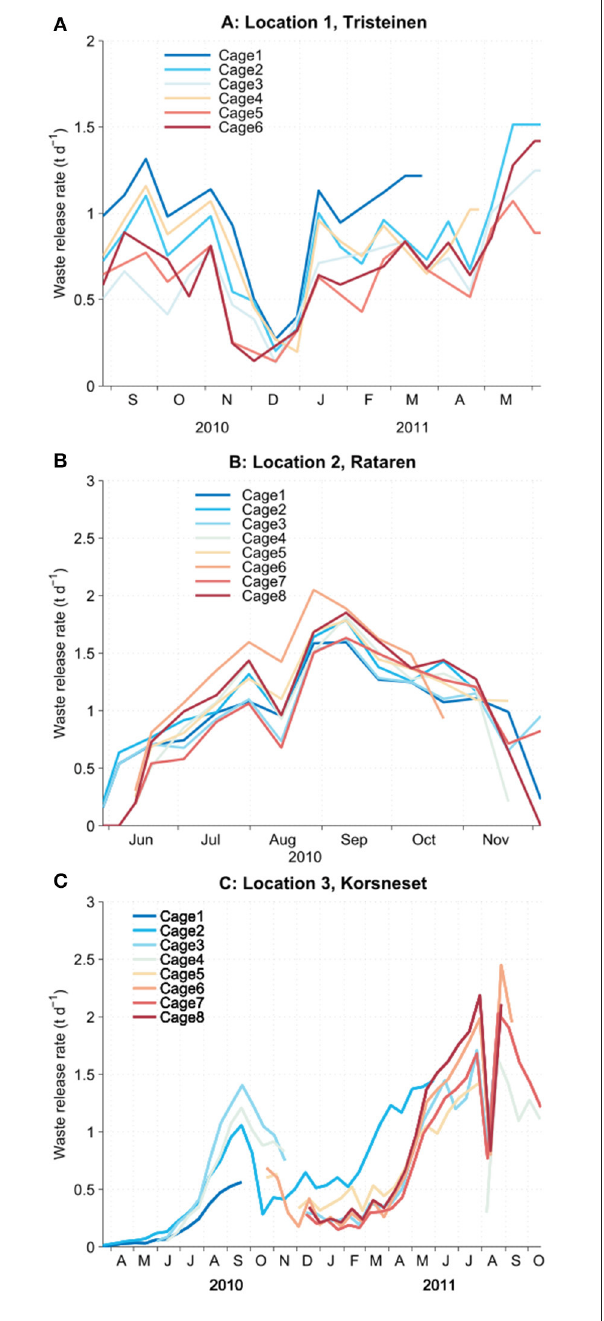
FIGURE 3 | Daily release rates of feed and feces wastes from each of the cages at locations 1 (A) , location 2 (B) , and location 3 (C) . Averages for 14 day periods were used in the simulations and are plotted in the